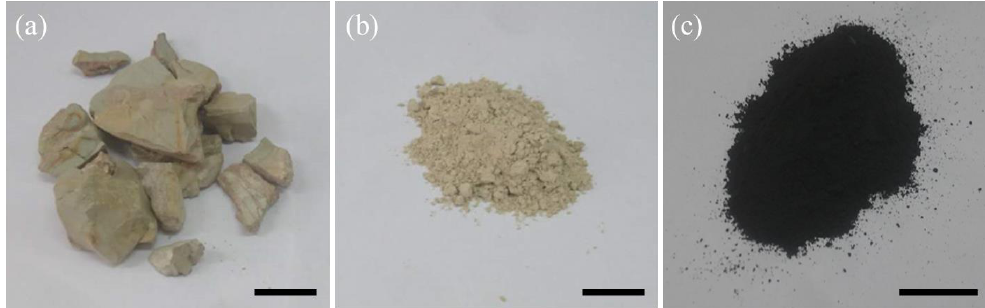
Figure 1. Digital camera images of ( a ) the crude mineral ore of attapulgite (ATP), ( b ) purified ATP and ( c ) the ATP/polypyrrole (PPy) nanocomposite. Scale bar: 1 cm.